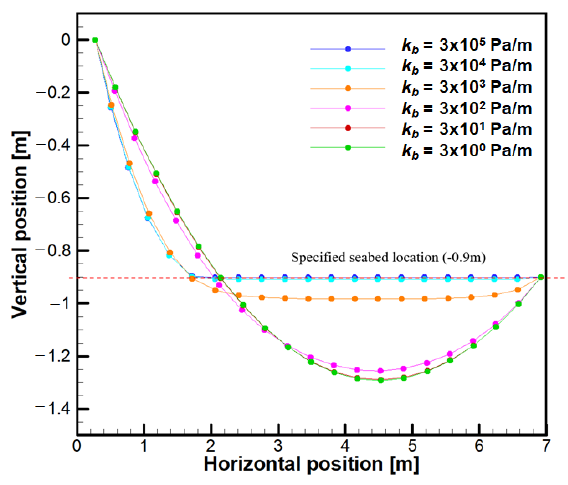
Figure 8. Node positions for various seabed